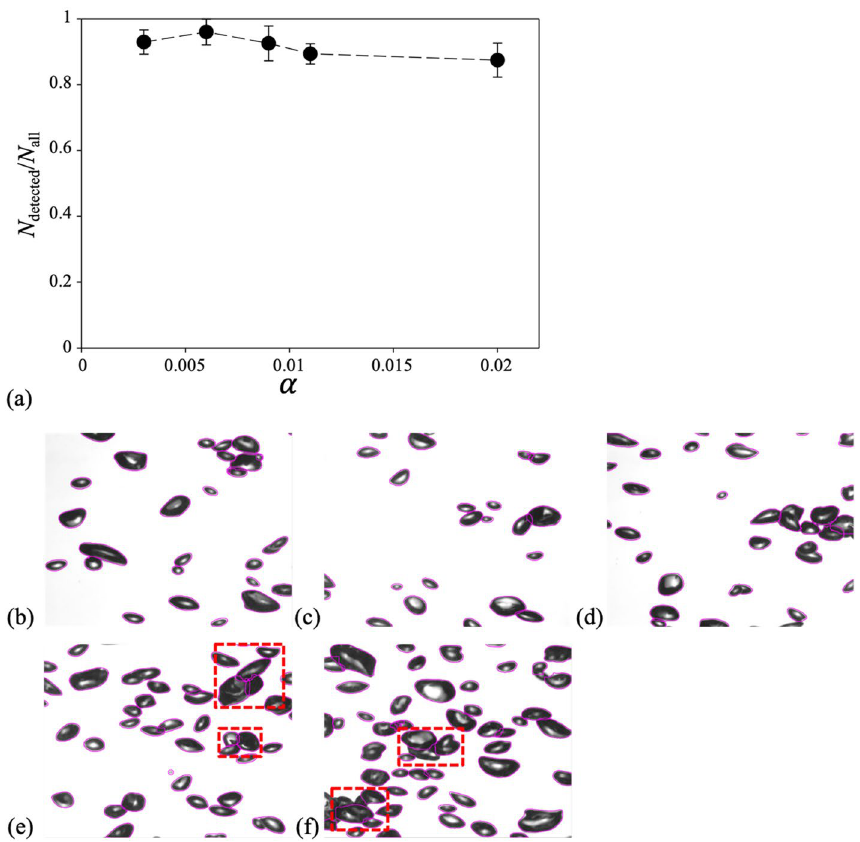
Figure 5. ( a ) Ratio of the number of detected bubbles ( N detected ) to the total number of bubbles in the bubble- swarm flow images 9 with volume void fraction (α). Representative bubble images with detection results (purple solid lines) are shown for α of ( b ) 0.003; ( c ) 0.006; ( d ) 0.009; ( e ) 0.011; ( f )